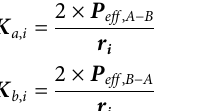
TABLE 2 | Physicochemical parameters and K t/p of CLOP and its metabolites in the PBPK-PD model. Physicochemical